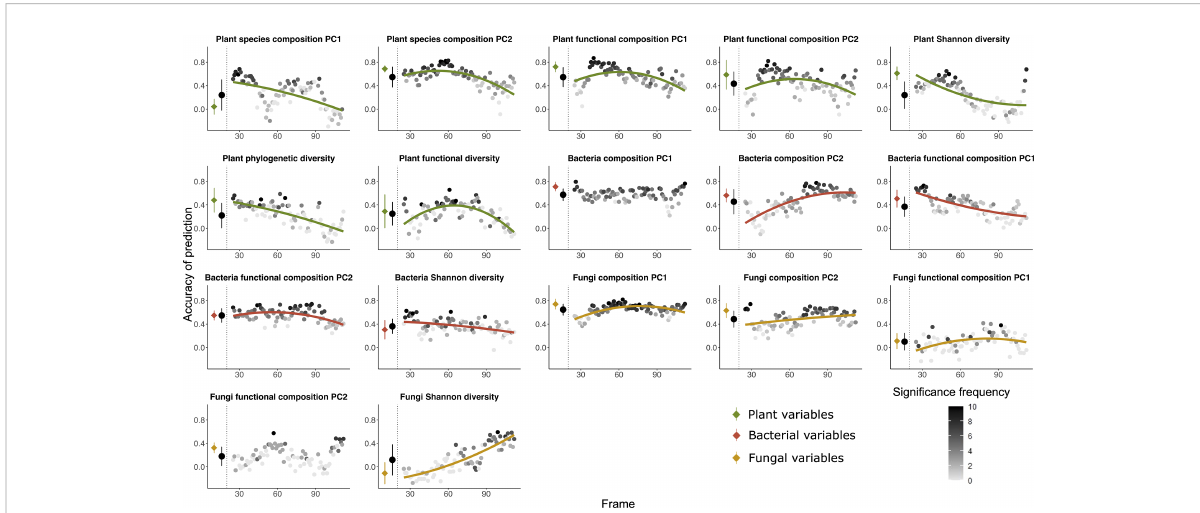
FIGURE 5 Random forest predictions using all the environmental factors as explanatory variable to predict seven variables of plant (green), fi ve variables of bacteria (red) as well as fi ve variables of fungi (orange) as dependent variables. The prediction was done both using all the 135 plots and using a moving frame approach. For the moving frame approach, every 45 plots were grouped into one frame and the median plot was used as identi fi er of the frame. Thus, the fi rst frame included plots 1 to 45, the second 2 to 46, and so forth. The x axis represents the median plot of every frame whose identi fi ers ranged from plot 23 to plot 113 (i.e. from young successional plots to old plots). The colored circles at the left of each plot denote the mean ± standard deviation of the accuracy of prediction (Pearson ’ s r) using the full dataset (results of 10-fold cross validation), and the black circles denote the mean ± standard deviation of the accuracy of prediction for all the frames. Each grey to black circle on the right of each plot represents the mean accuracy of prediction of each frame and the color gradient is showing how many correlations of the 10-fold cross-validation were signi fi cant with lighter colors indicating less frequent signi fi cant predictions. A quadratic or linear regression (the model with higher adjusted r 2 value) is fi t for the gradient if it is signi fi cant, showing a change of the accuracy of prediction along the successional